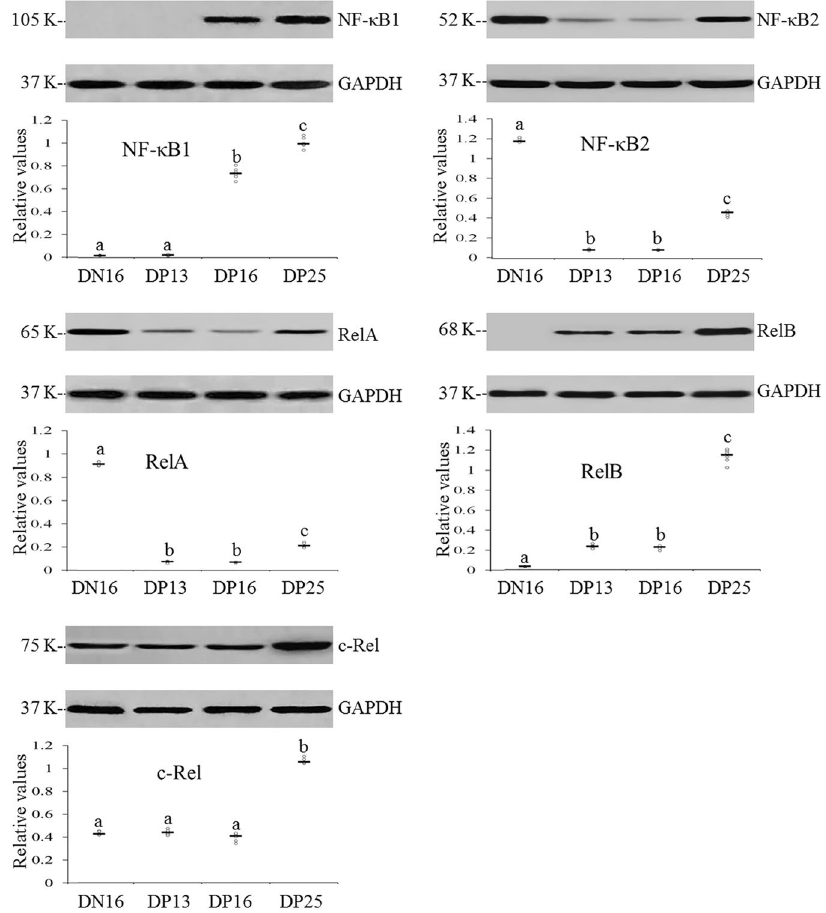
Figure 2. Expression of NF-κB1, NF-κB2 RelA, RelB, and c-Rel proteins in the thymus from non-pregnant and pregnant ewes (n = 6 for each group). Note: DN16 = day 16 of the estrous cycle; DP13 = day 13 of pregnancy; DP16 = day 16 of pregnancy; DP25 = day 25 of pregnancy. Significance is denoted by letters; if two groups have different letters, this indicates that the difference between these groups was significant with P <